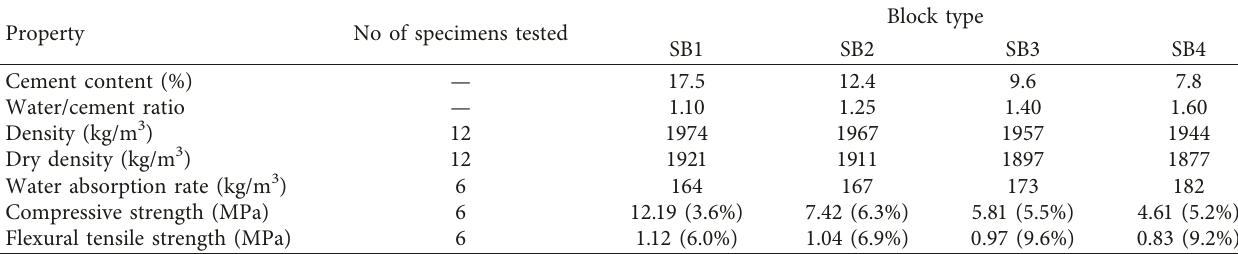
Figure 1: Compressive test setup (a) block, (b) mortar cube, and (c) masonry Table 4: Properties of stabilized earth blocks.